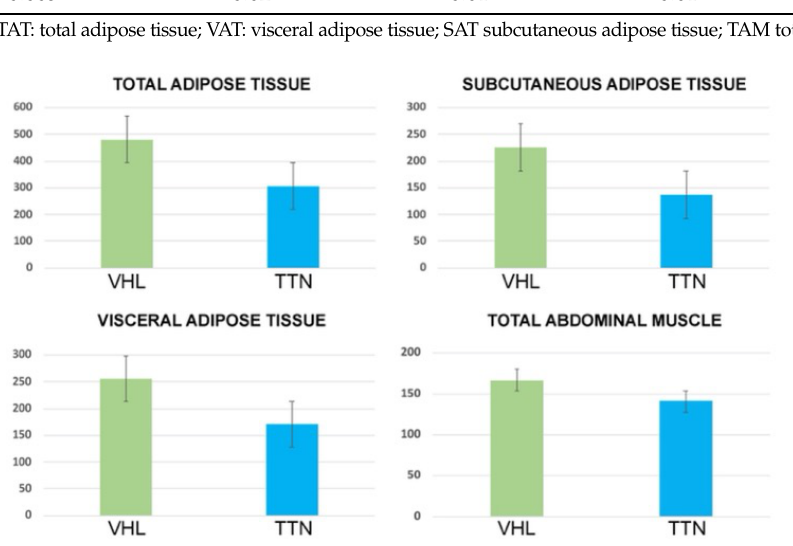
Figure 5. Bar chart with error bars showing a significant difference of mean values of TAT, SAT, VAT and TAM areas between ccRCC-VHL group and ccRCC-TTN group.